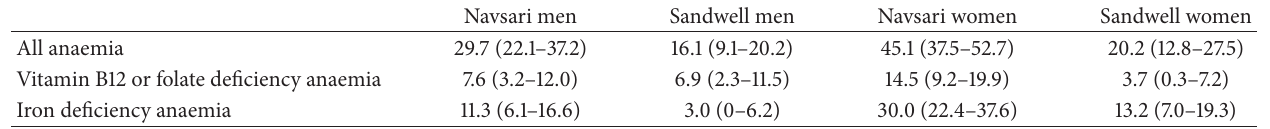
Table 2: Age-adjusted prevalence of anaemia amongst Indian Gujaratis by residence and gender.